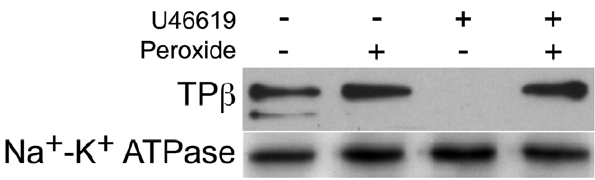
Figure 9. Effect of hydrogen peroxide on ligand-induced internalization of TP b . HA-TP b internalization in response to U46619 was studied in HEK293 cells stably expressing TP b , both in the absence and presence of H 2 O 2 . Cultures were treated with H 2 O 2 (10 m M) for 40 minutes prior to the addition of U46619 (600 nM) and incubated for a further 90 minutes at 37 u C. Cell-surface proteins were labelled with a water-soluble biotin analogue followed by adsorption onto streptavidin beads. HA-TP b was detected with anti-HA antibodies following electrophoresis and transfer to membrane and loading equivalence assessed by reprobing membranes with Na + -K + ATPase